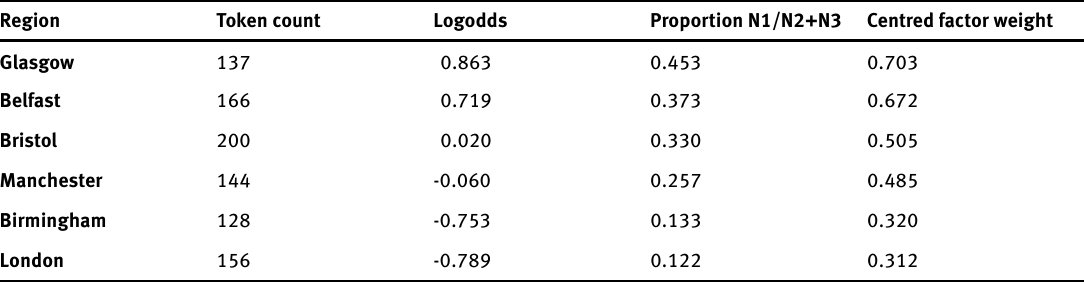
Table 6: Mixed effects variable rule analysis of N1 v N2+N3, interaction with region Region Token count Logodds Proportion N1/N2+N3 Centred factor